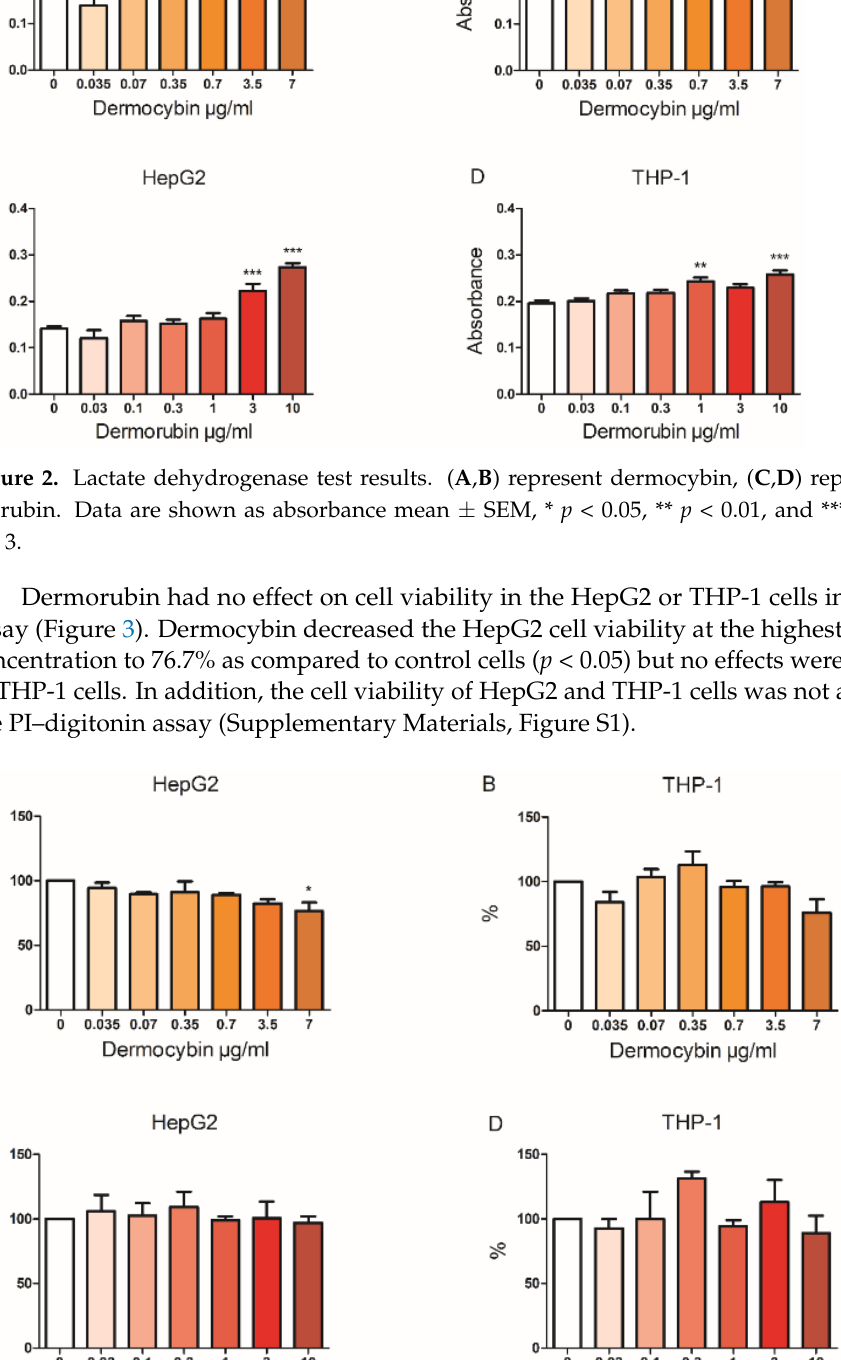
19 of 18 Table 2. Wash fastness ( ∆ E, color change and staining) and rubbing fastness assessment results obtained from polyester fabric dyed with blood-red webcap dyes in Sc-CO 2 . Natural Dye